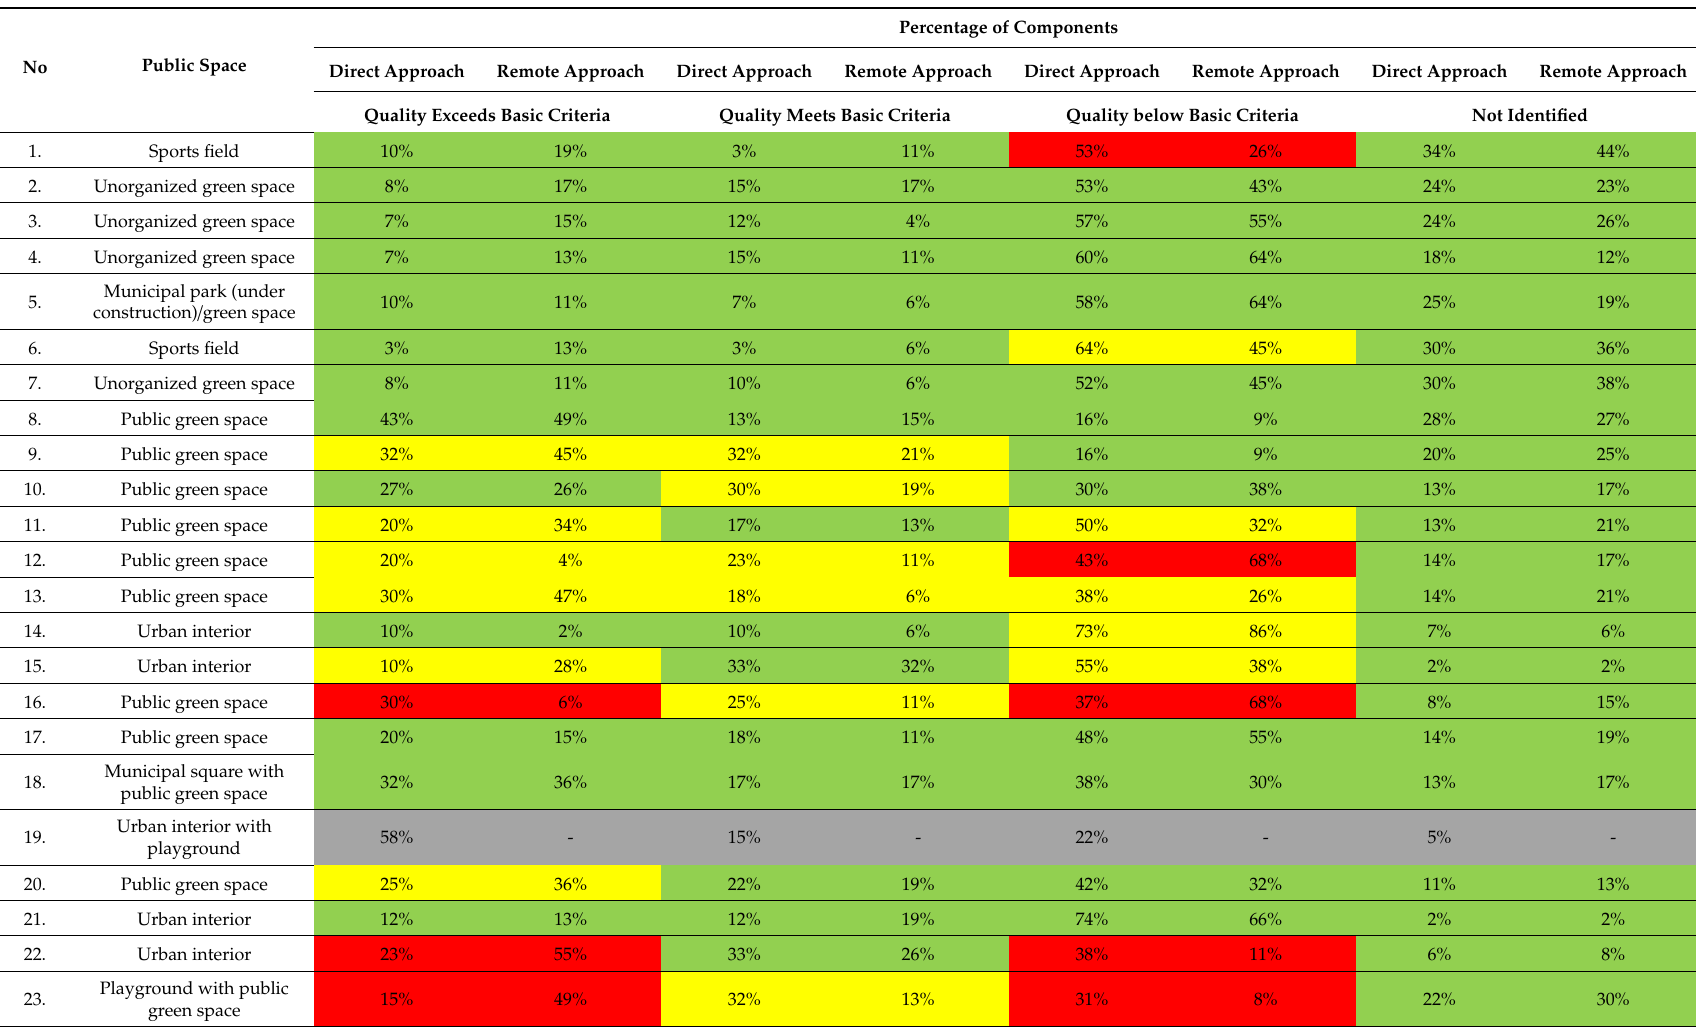
Table 4. An evaluation of the quality of public spaces—a comparison of the results of direct and remote analyses for Orneta. Source: own